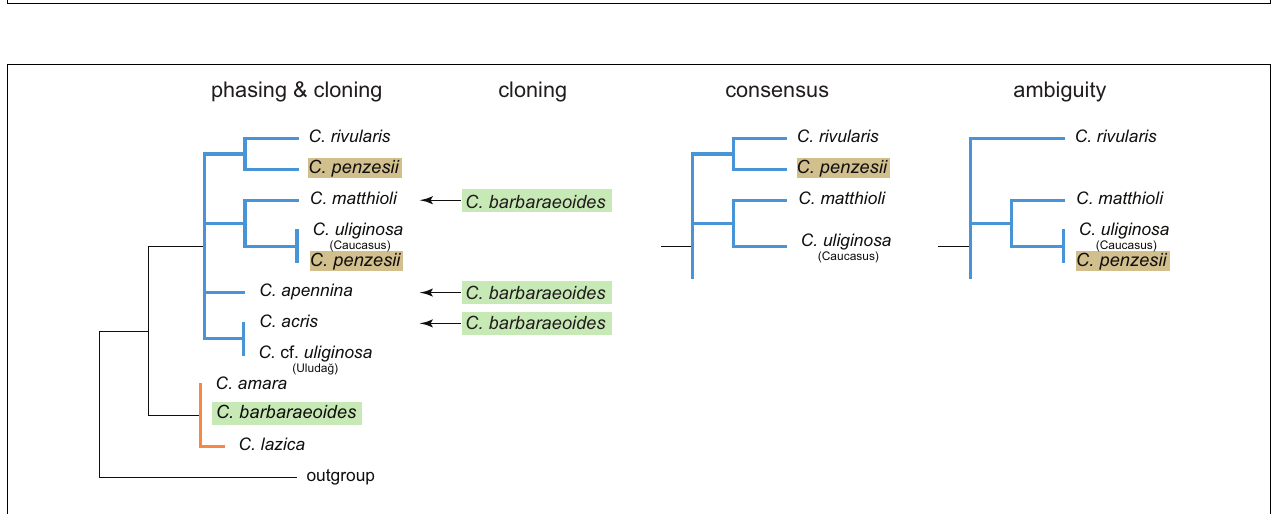
FIGURE 6 | Schematic representation of maximum likelihood (ML) trees inferred from four datasets of nrDNA (ITS1-5.8S-ITS2 region) and their topological differences. Cloning: dataset obtained from molecular cloning and Sanger sequencing; phasing: dataset obtained from read-backed phasing of Hyb-Seq reads, with multiple nrDNA variants retrieved per sample; consensus: consensus assembly (with the majority rule base calls) from Hyb-Seq reads; ambiguity: ambiguous assembly from Hyb-Seq reads with intraindividual SNPs replaced by IUPAC codes. See Supplementary Figure 6 for the complete ML trees obtained from these